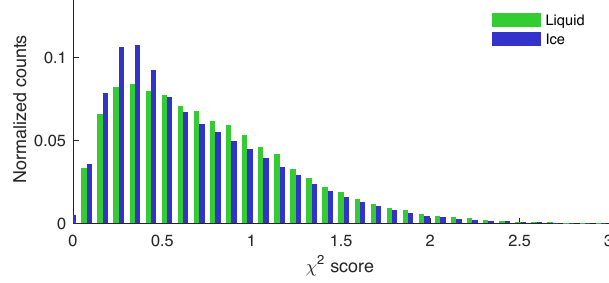
Figure 4. Normalized histogram of χ 2 spectrum fit scores for the entire scene of Figs. 2 and 3. Low χ 2 values indicate good fits; χ 2 = 1 is a conservative estimate of measurement